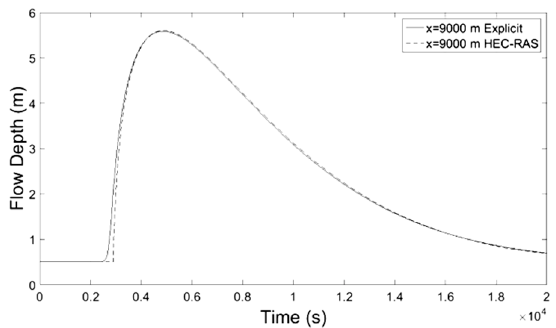
Figure 7. Flow Depth-Time at x = 9000 m.